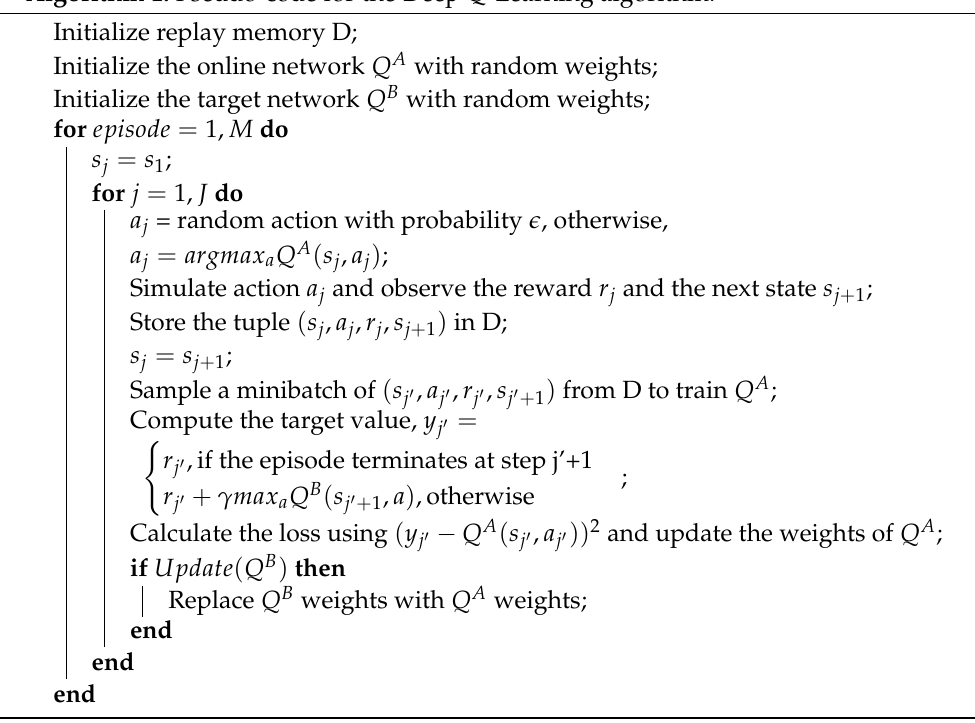
Algorithm 1: Pseudo-code for the Deep Q-Learning